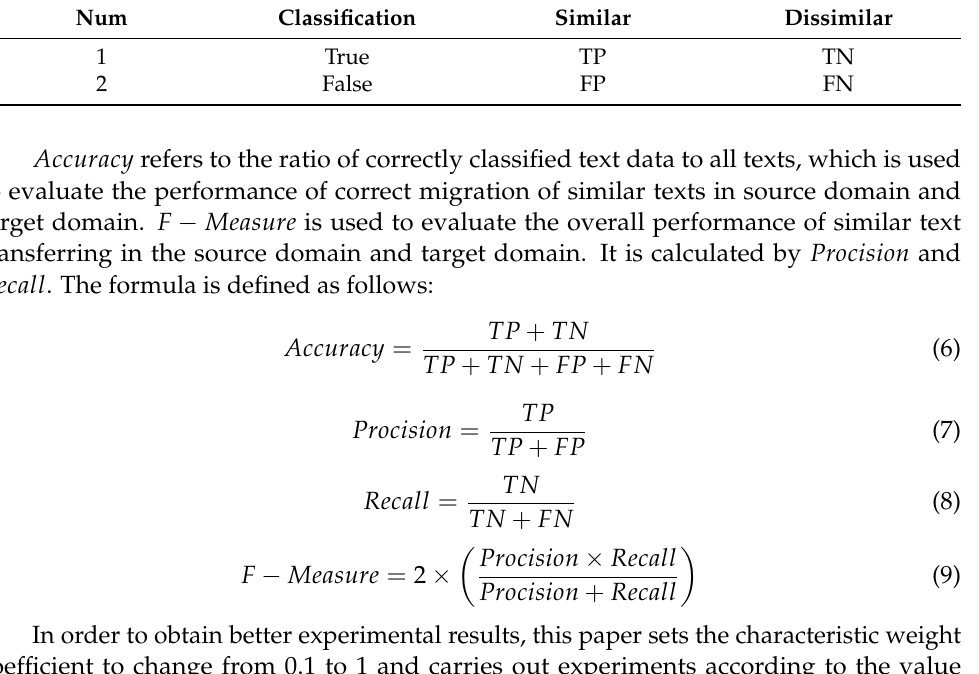
Table 4. Accuracy and F-measure Parameters. Num Classification Similar